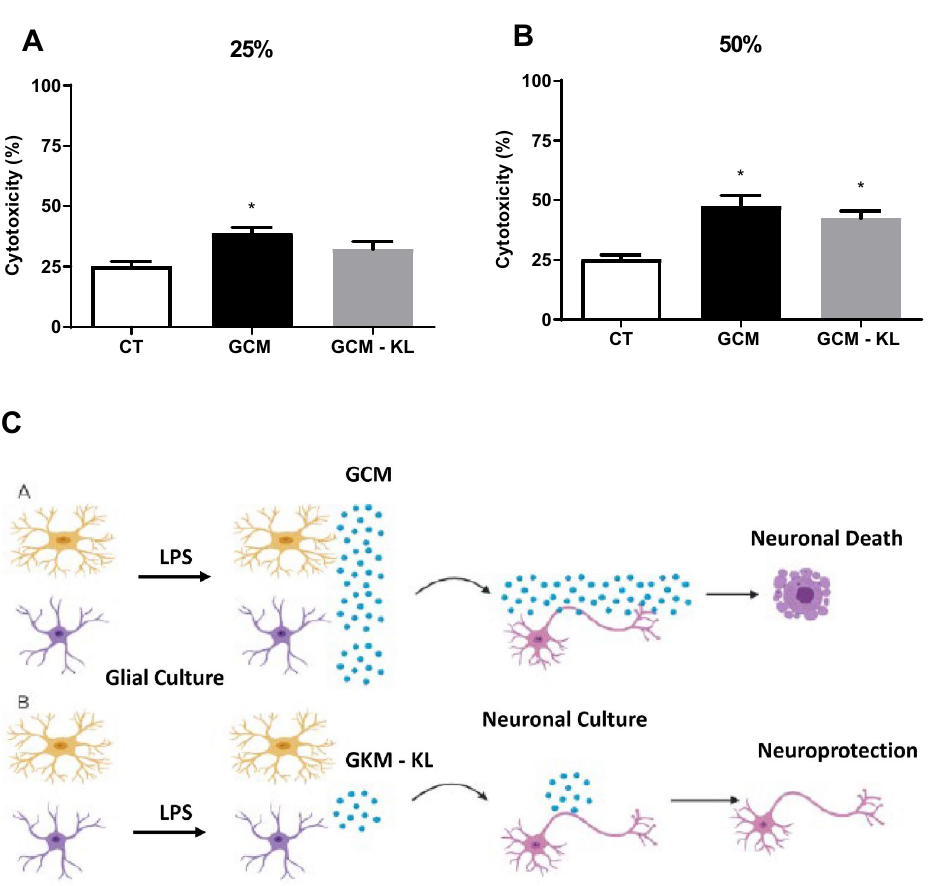
Figure 7. Effects of Klotho on GCM -induced cytotoxicity of primary cortical mouse neurons. The primary embryonic culture of neurons was submitted to 24-h treatment with GCM in different concentrations, 25% ( A ) and 50% ( B ) in the presence or absence of KL. Cytotoxicity was assessed by the LDH assay. One-way ANOVA analysis, followed by Tukey’s post-test, *p < 0.05, Results are presented as mean ± SEM of 5 independent experiments. ( C ) Representative schedule of the neuroprotective effect of α-Klotho protein on GMP-induced cytotoxicity of neurons. LPS induces GCM to produce pro-inflammatory mediators that can lead to neuronal death ( A ). α-Klotho protein decreases the production of pro-inflammatory mediators induced by LPS in GCM ( B ), and it can have a protective effect on neurons from the neurotoxic effects of LPS induced by GCM. The figure was “Created with BioRender.com—Agreement number FH248VCXX8 to Scientific Reports ”.